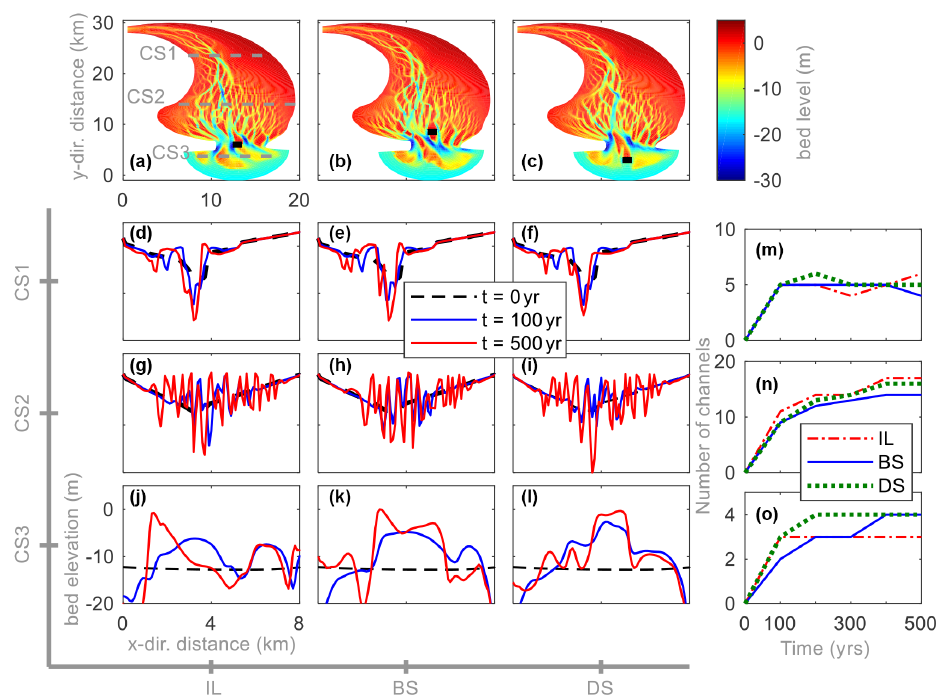
Figure 6. Morphological evolution after 500 years (a–c) of a basin with a mouth island at the inlet (“IL”), at the basin side (“BS”) and the delta side (“DS”), respectively. Panels (d) – (l) represent the temporal cross-sectional bed elevation of different cases: (d) – (f) cross section 1; (g) – (i) cross section 2 and (j) – (l) cross section 3. Panels (m) – (o) represent the number of channels of different cross sections, respectively. In some subplots, the black rectangular area represents the mouth island and the dotted grey lines represent the cross-section position.